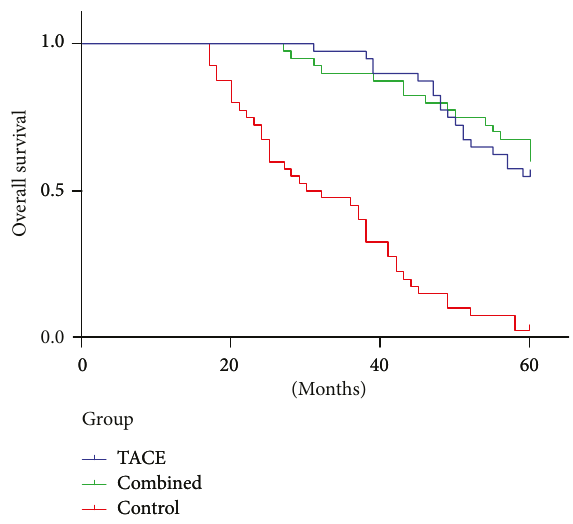
Figure 2: OS of patients in di ff erent groups.